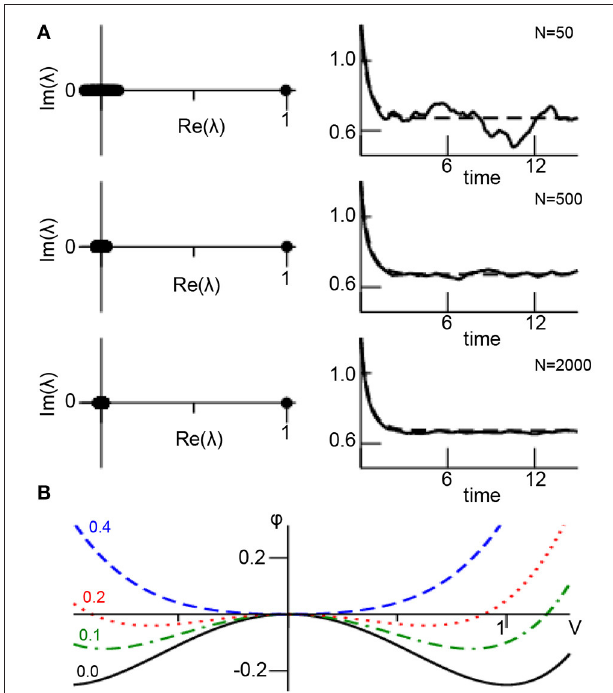
FIGURE 1 | Mean-field description of ANISE. (A) The spectral distribution of random matrix K for different number of network nodes N (left column) and corresponding network mean (solid line, from Equation 1) and mean-field (dashed line, from Equation 4) for comparison (right column). Parameters are K 0 = 1.0, D = 0.1, γ 1 = 2.0, γ 2 = 0.0, γ 3 = − 1.0, α = β = 0.0, c = 0.9 and numerical integration time step 1 t = 0.03 utilizing the Euler-Maruyama integration method and identical initial values V i = 1.1 at t = 0 for all parameters. The panels show results for a single network realization, while the variance of results for multiple network realizations is found to be negligible for N ≥ 1,000 (data not shown). (B) Potential φ ( V ) for different noise variances D